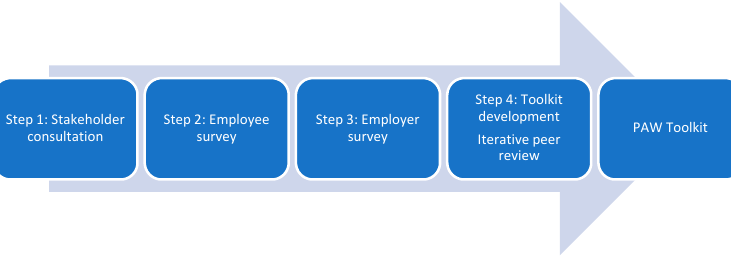
Figure 1. Four-step Agile development process.